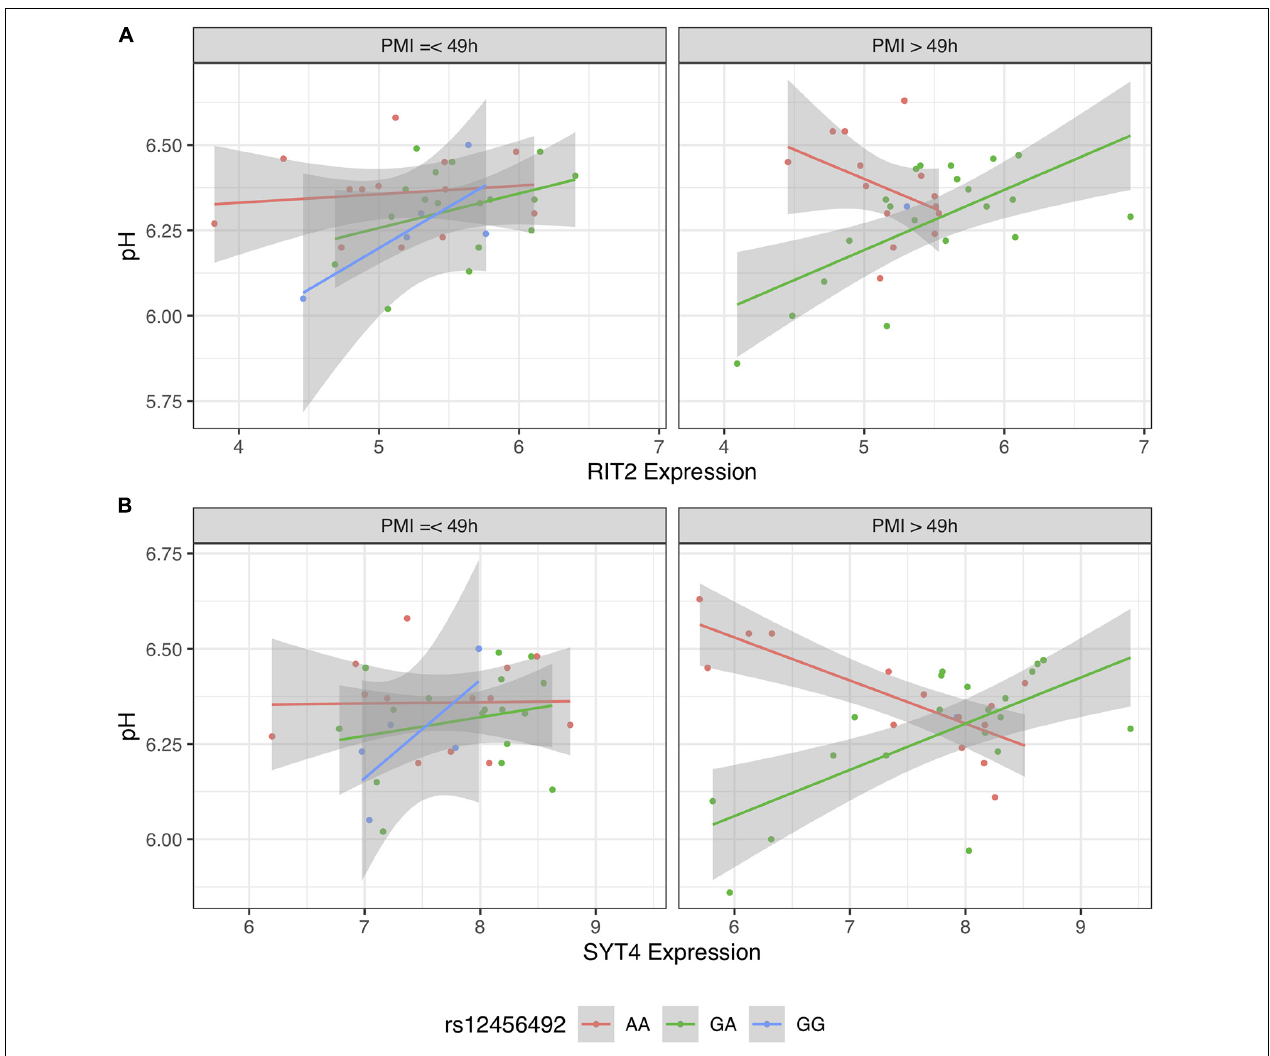
FIGURE 8 | Scatter plot of pH and gene expression grouped by risk single nucleotide polymorphism (SNP) genotype and stratified PMI within BrainEAC sample for RIT2 (A) and SYT4 (B) . Genotype groups are colored with lines representing linear fits with shaded areas marking the 0.95 confidence